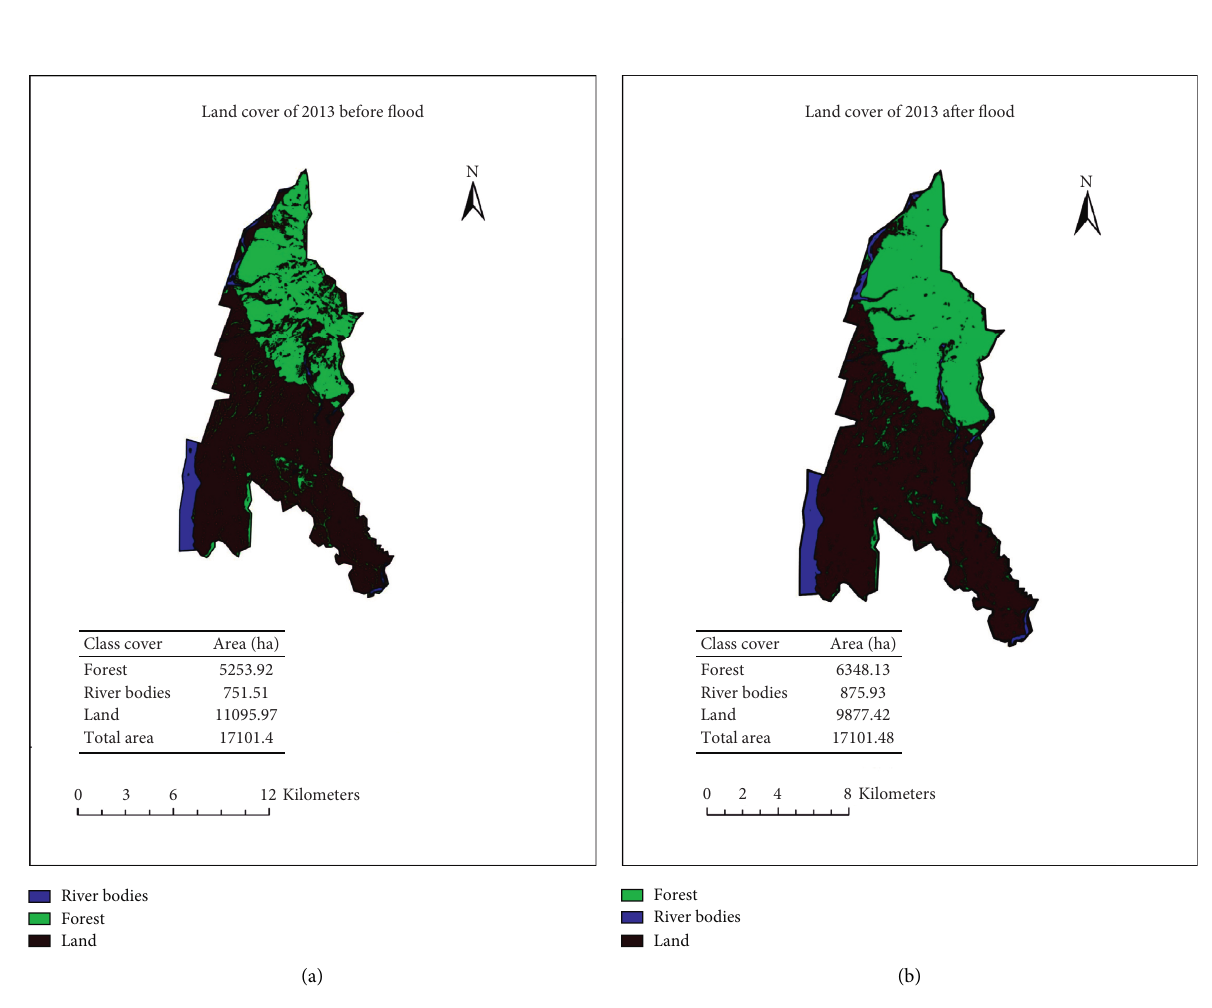
Figure 2: Land cover image before and after flood.